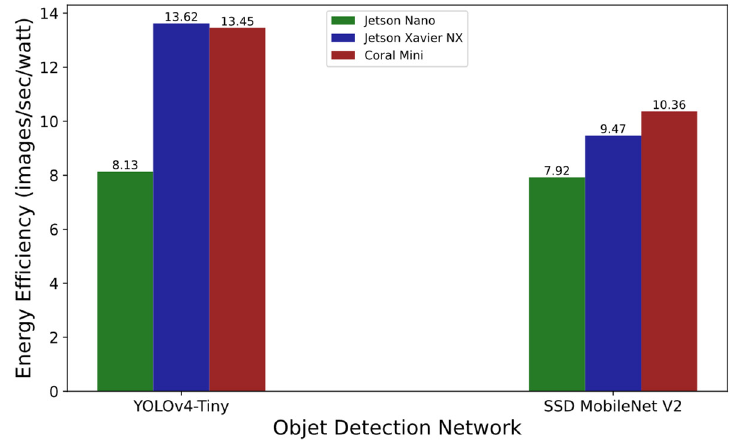
Figure 6. Energy Efficiency Measurement Results of the Devices.